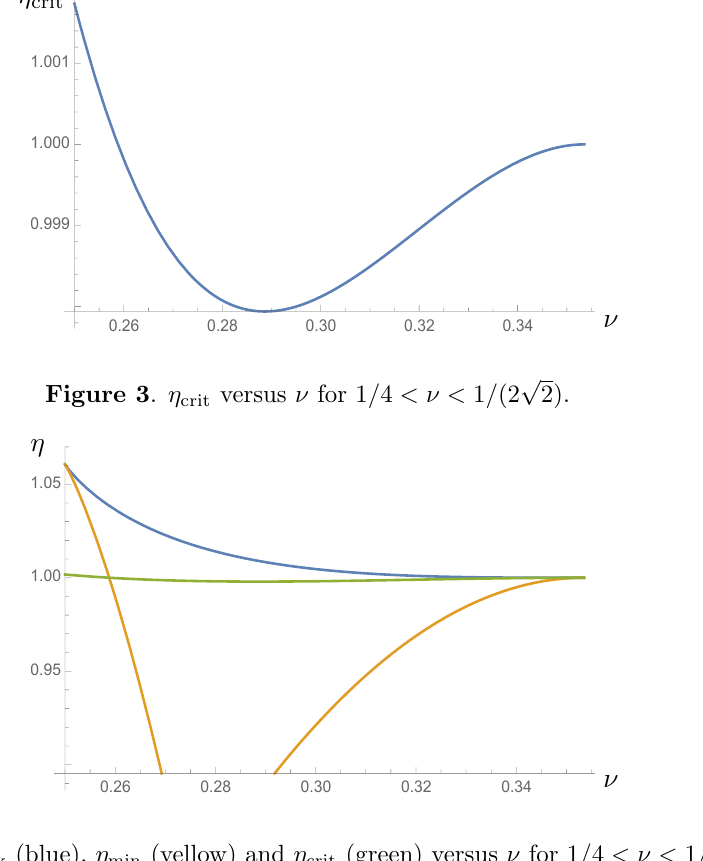
Figure 4 . (cid:17) max (blue), (cid:17) min (yellow) and (cid:17) crit (green) versus (cid:23) for 1 = 4 < (cid:23) < 1 = (2